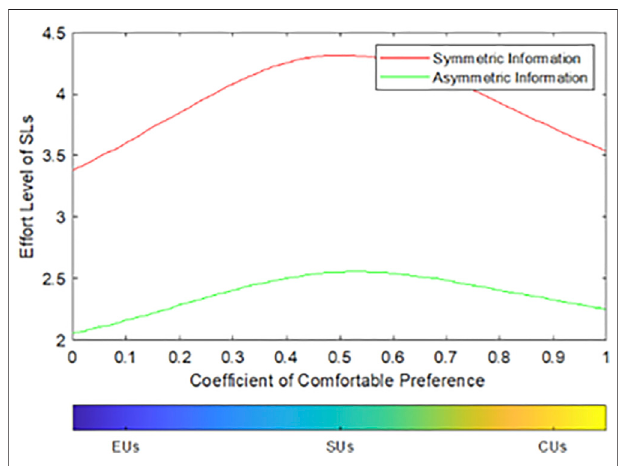
FIGURE 2 | Relationship between the effort level and SLs ’ type under different information conditions.